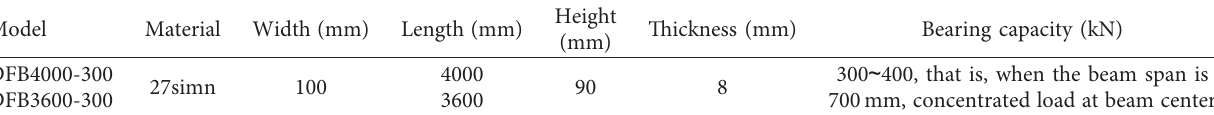
Table 3: The main technical characteristics of π type steel beam.